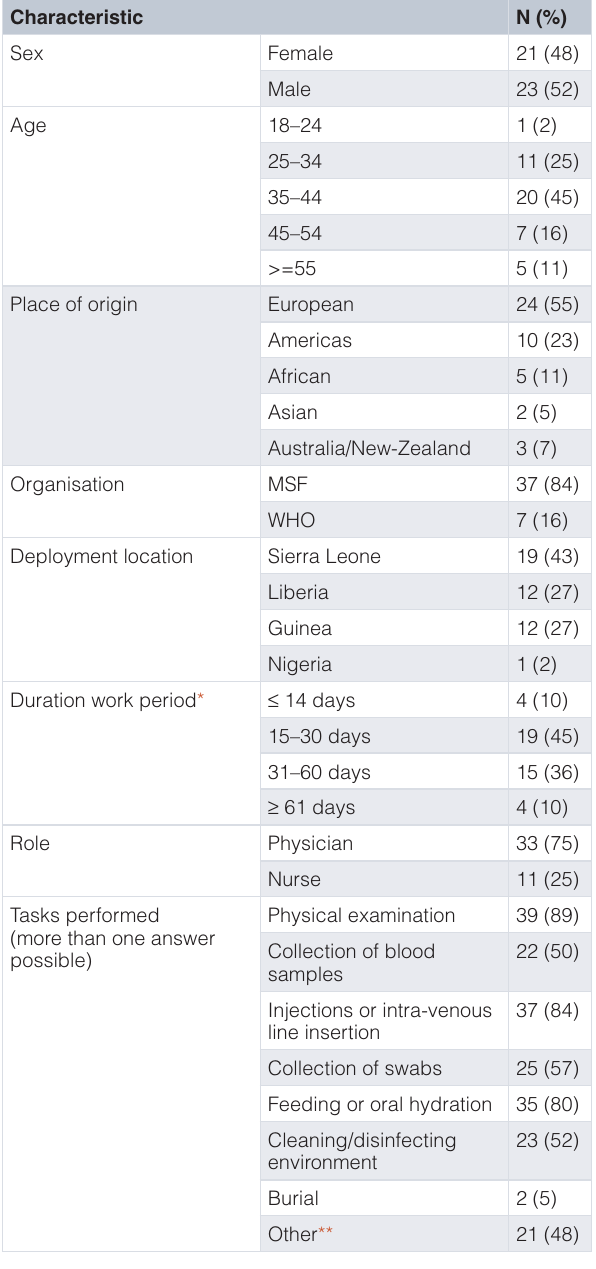
Table 1. Characteristics of survey participants